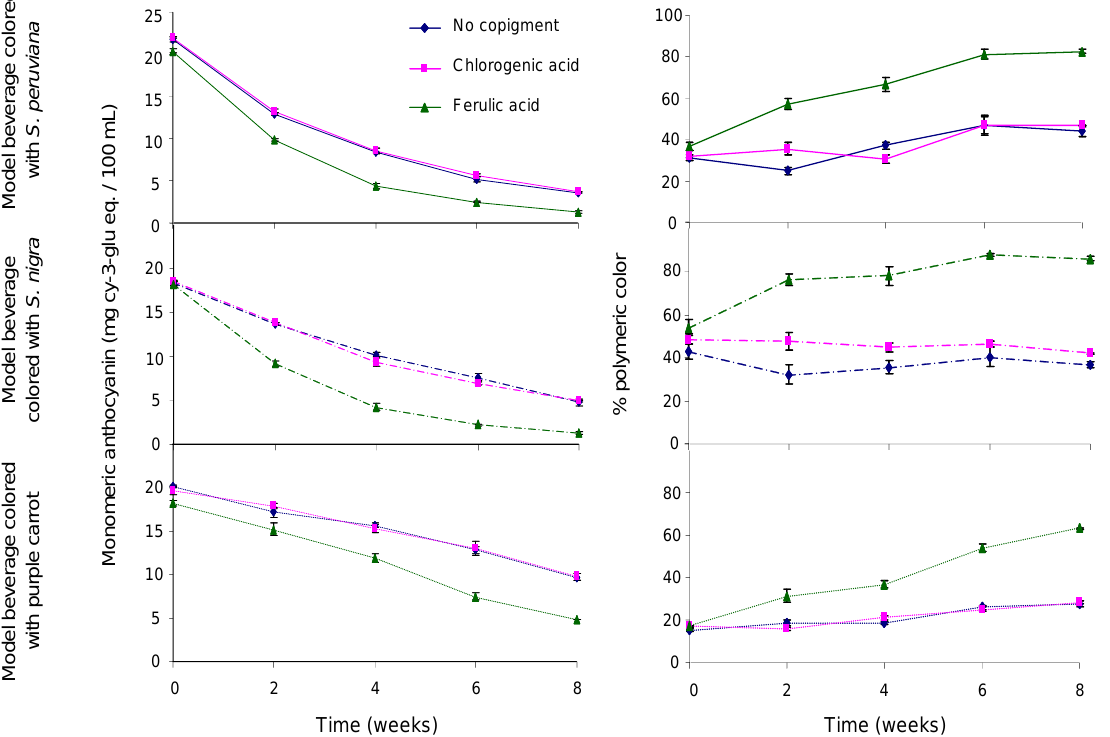
Figure 1. Effect of copigmentation on the monomeric anthocyanin content (left) and percent of polymeric color (right) in model beverages colored with S. peruviana (upper), S. nigra (middle), and purple carrot (lower). Model beverages with no copigment (blue line), with chlorogenic acid (pink line), and with ferulic acid (green line).